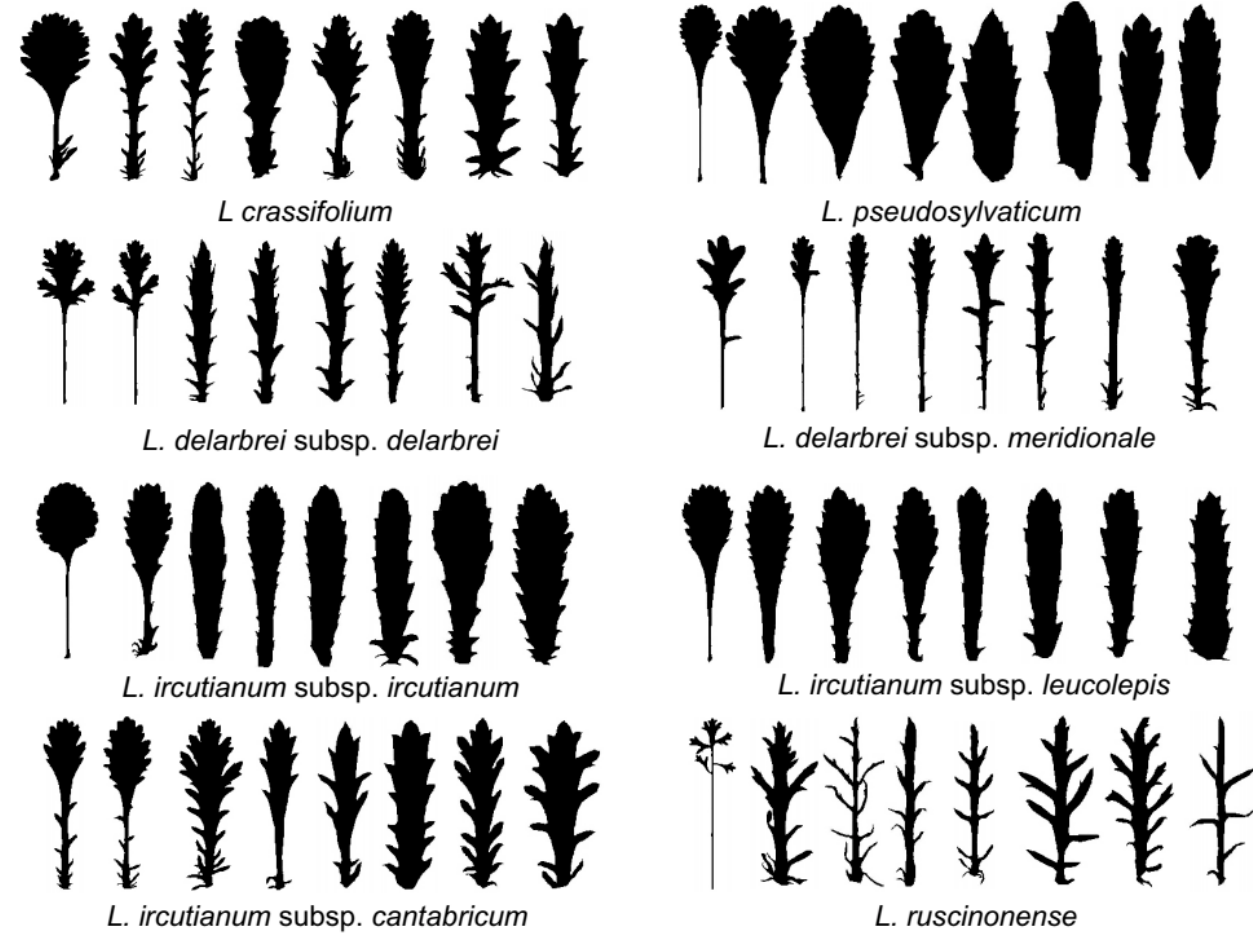
Figure 5. Silhouettes of basal and cauline leaves from different accessions of the eight tetraploid Leucanthemum taxa under study.